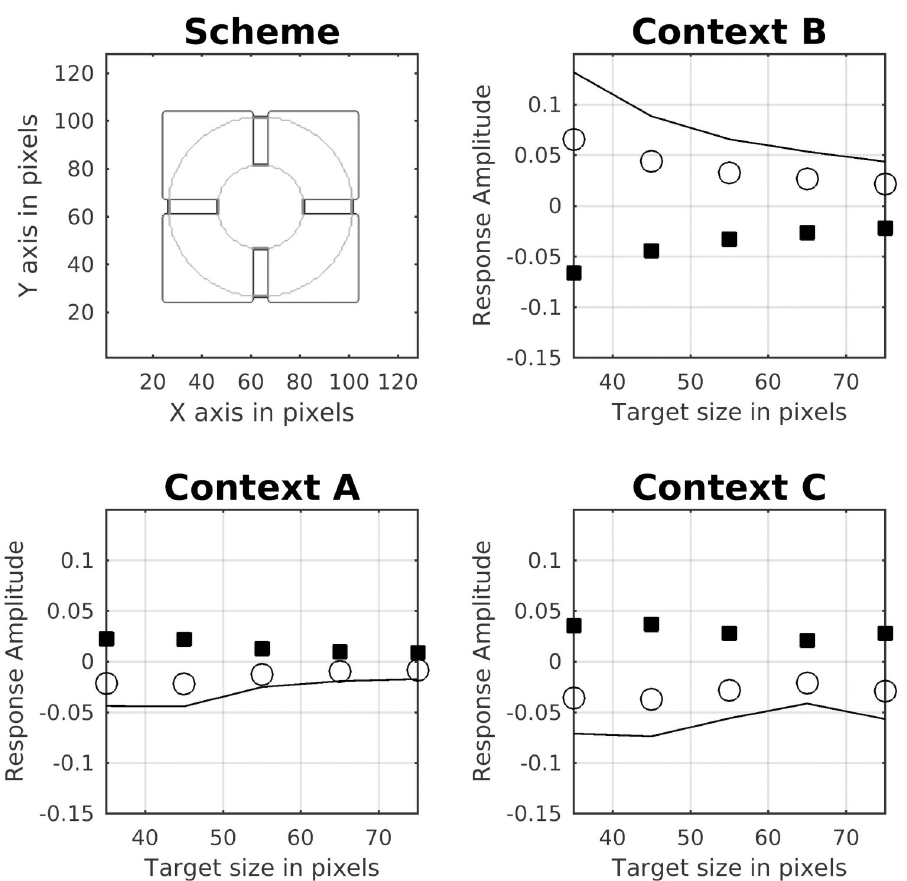
effect for each of the three Contexts shown in Fig 14. The empty circles indicate the predicted brightness of the disk with the white squares. The filled symbols show disk brightness with the black squares. The continuous lines show the estimated brightness difference between both disks and indicate the predicted strength of the